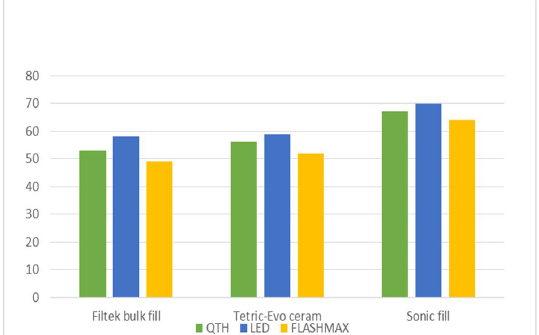
Figure 2: Chart for the microhardness value for the three tested materials top surfaces